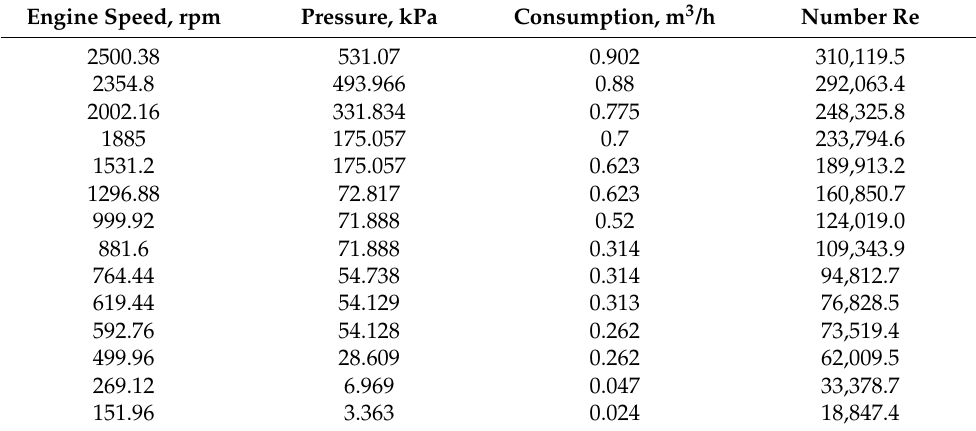
Table 1. Results of the